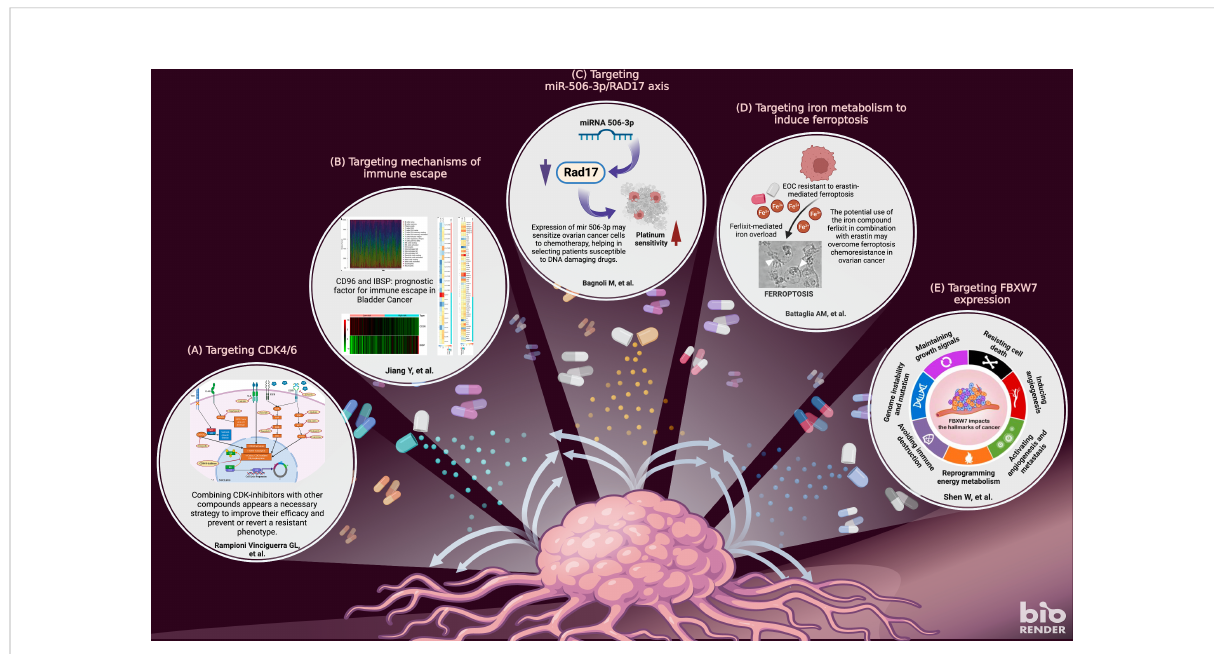
FIGURE 1 The fi gure highlights the topics covered in the research articles included in this special issue. The articles provide a detailed overview of fi ve important topics in tackling chemoresistance in cancer: targeting cyclin-dependent kinases (A) ; targeting immune escape (B) ; targeting miR- 506/RAD17 axis (C) ; targeting ferroptosis (D) ; protein FBXW7 factor (E) . Adapted from “ New strategies for treating cancer ” by BioRender.com (2022). Retrieved from